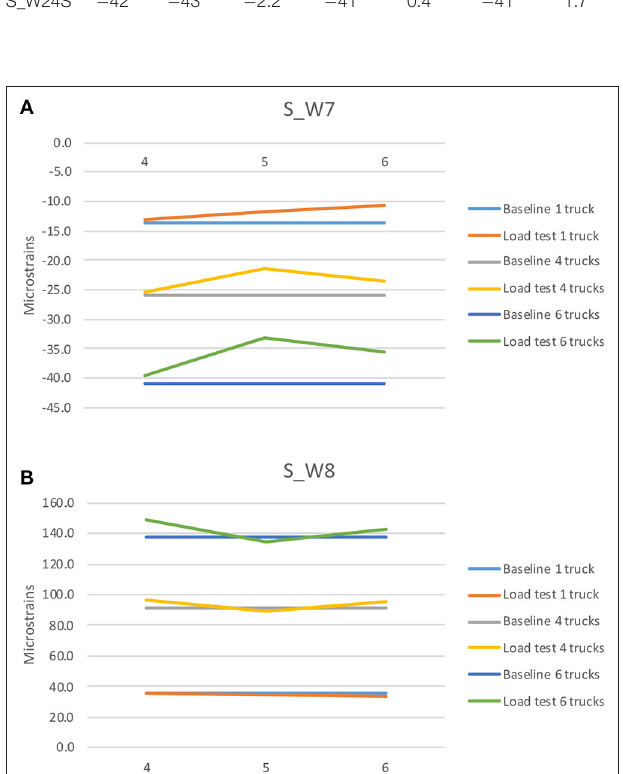
FIGURE 6 | Peak strains at midspan from load tests 4, 5, and 6 compared to the baseline value: (A) top of west edge girder; (B) bottom of west edge girder.